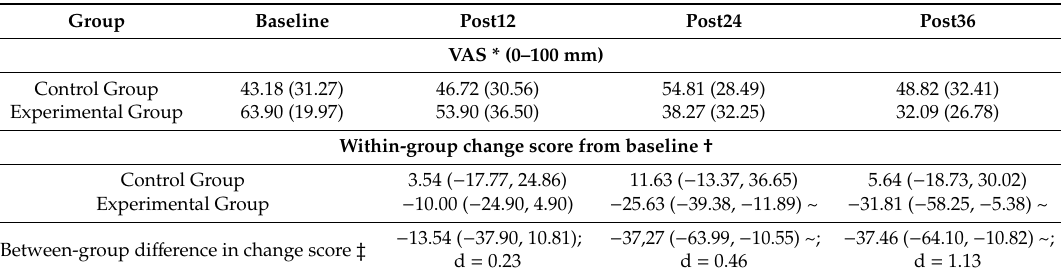
Table 2. Self-reported knee pain data.